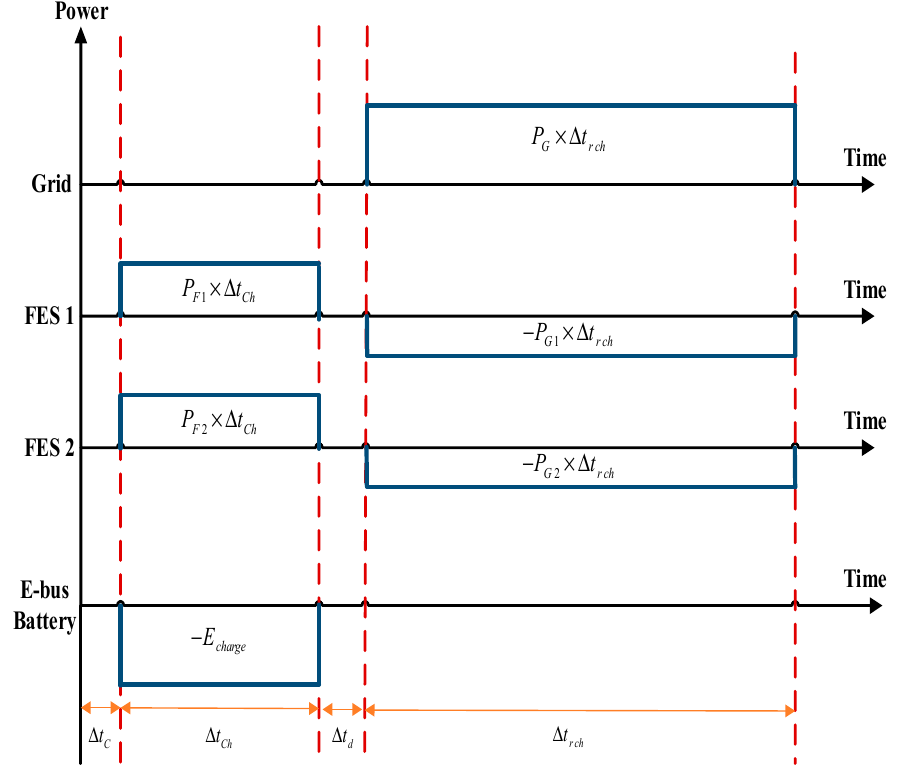
Figure 7. Proposed flash charging duty cycle.